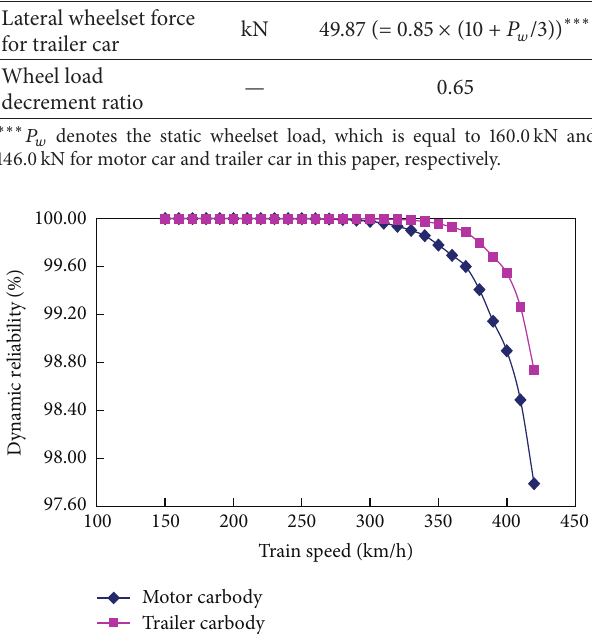
Figure 11: Dynamic reliability for carbody vertical acceleration with respect to train speed.